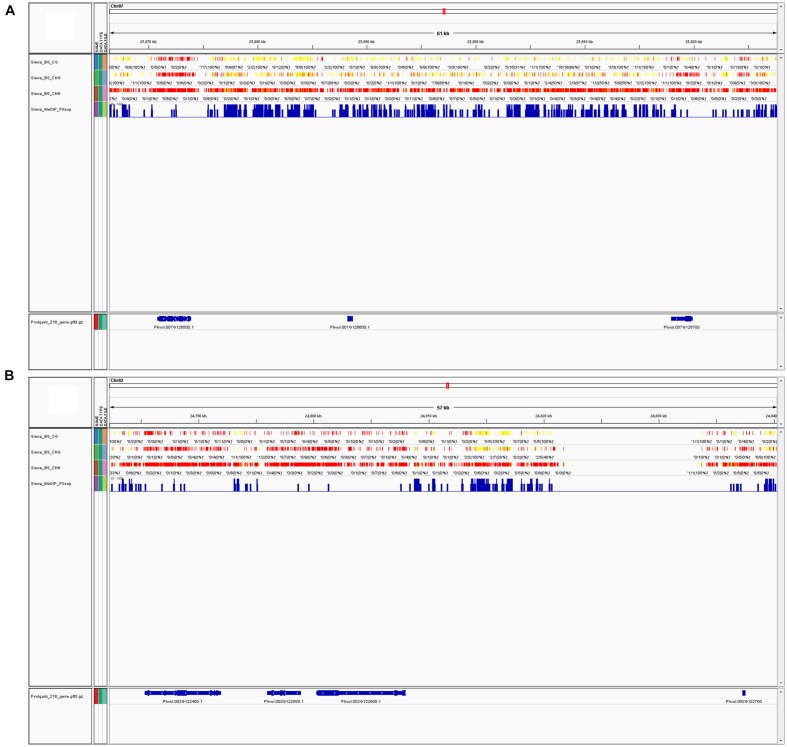
(A) MeDIP-Seq and BS-Seq data can be visualized in a single window with a genome viewer. In the screenshot, BS-Seq tracks are included for a segment of chromosome 7 (Chr07, position 25,866,407-25,927,674) showing CG, CHG, and CHH sites for from BS-Seq data, and the fourth track is of MeDIP-Seq peaks. These tracks were viewed via the Integrative Genome Viewer (IGV) program. Chr07 is one of the most highly methylated bean chromosomes, as determined by MeDIP-Seq peak density. Yellow indicates high methylation, while red indicates low or no methylation. (B) Screenshot of a segment of chromosome 2 (Chr02, position 24,782,253-24,840,303) via IGV, which is one of the least methylated bean chromosomes, as determined by MeDIP-Seq peak density. Both figures show approximately 60 Kb of sequence at the furthest possible zoom scale to visualize BS-Seq and MeDIP-Seq data in one window.